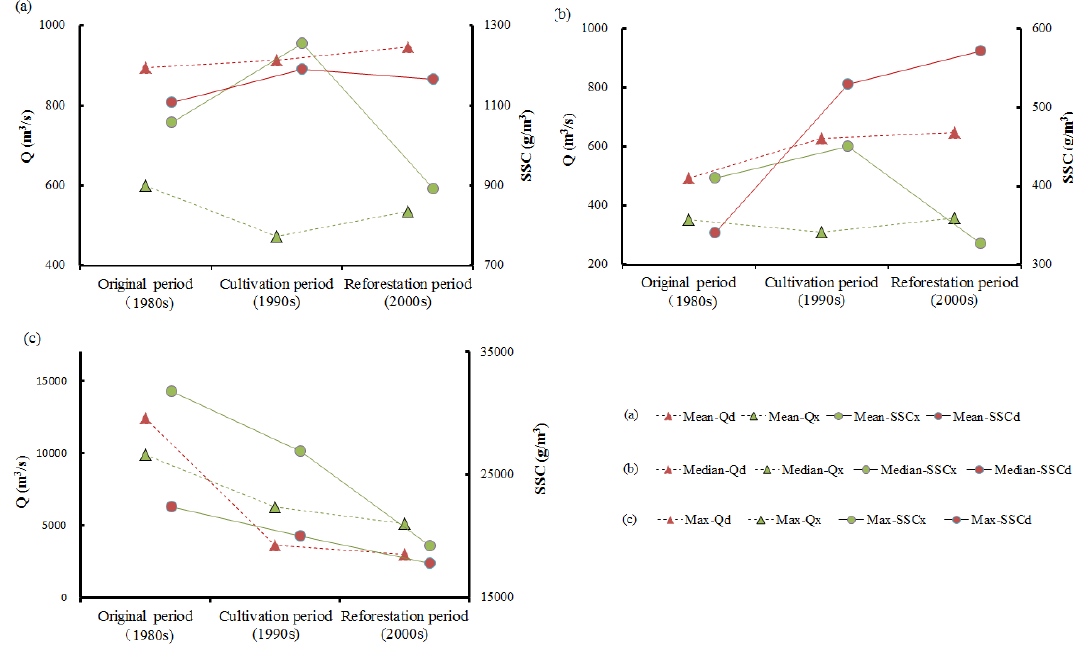
Figure 6. Descriptive statistics of Q and